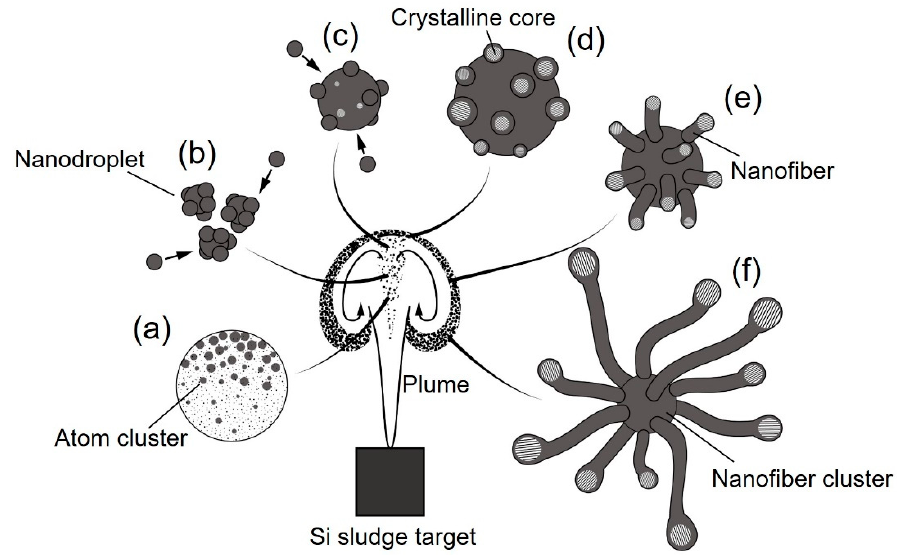
Figure 14. Schematic diagram of the mechanism of urchin-like silicon nanofiber cluster formation in a dense vortex: ( a ) atom clustering, ( b ) nanodroplet generation, ( c ) nanodroplet growth, ( d ) crystalline core nucleation, ( e ) nanofiber growth, and ( f ) nanofiber cluster formation.